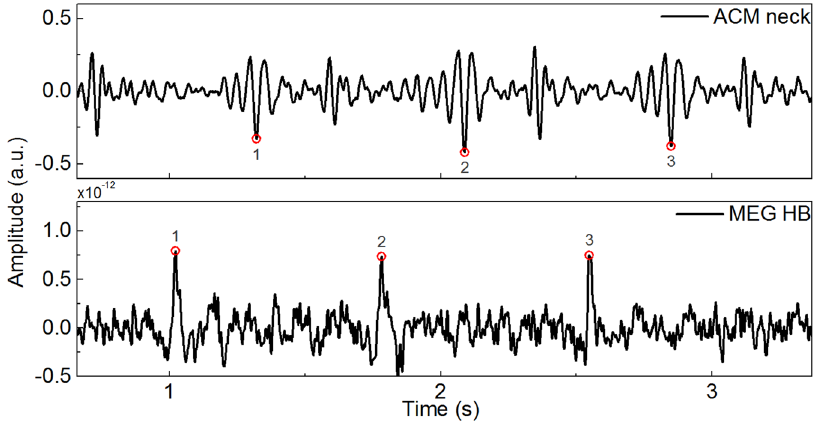
Figure 5. Raw signals recorded during resting state. Lower signal showing peaks for heart beats is recorded by one MEG channel and above it is shown response of the ACM placed on the neck of the patient. In both signals the heart pulsation can be observed.